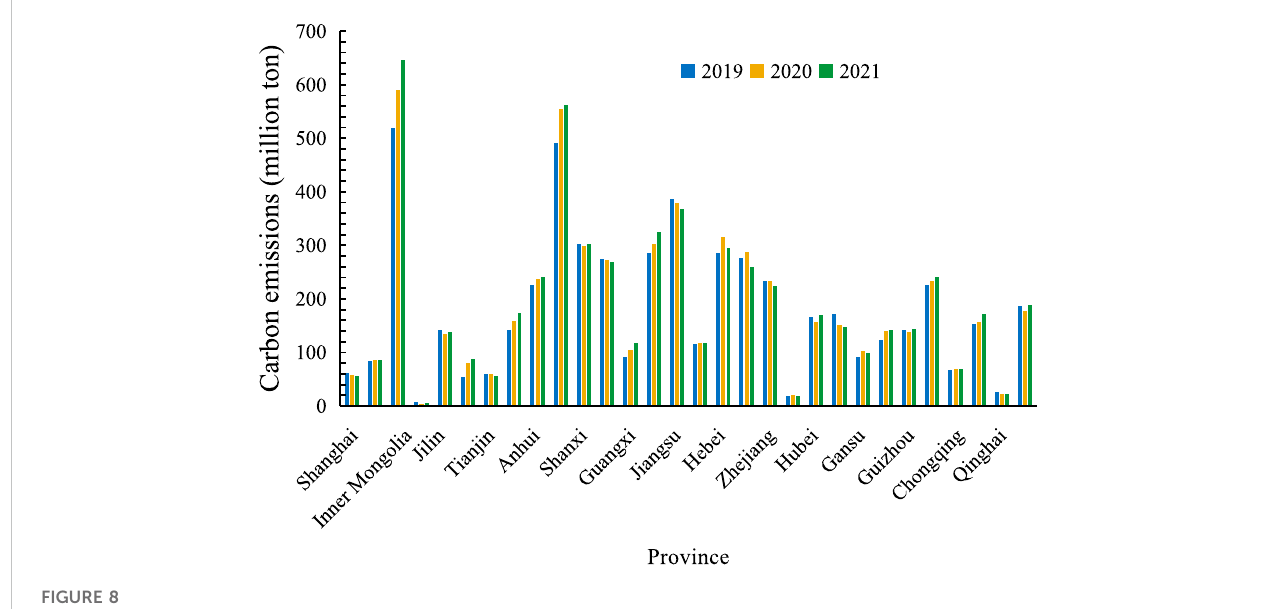
FIGURE 8 Change in Total Carbon Emissions of different